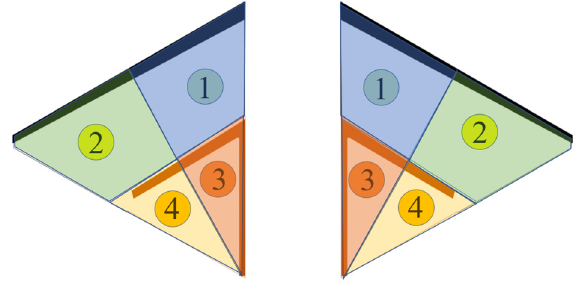
Figure 11. Regions of pectoral fin.